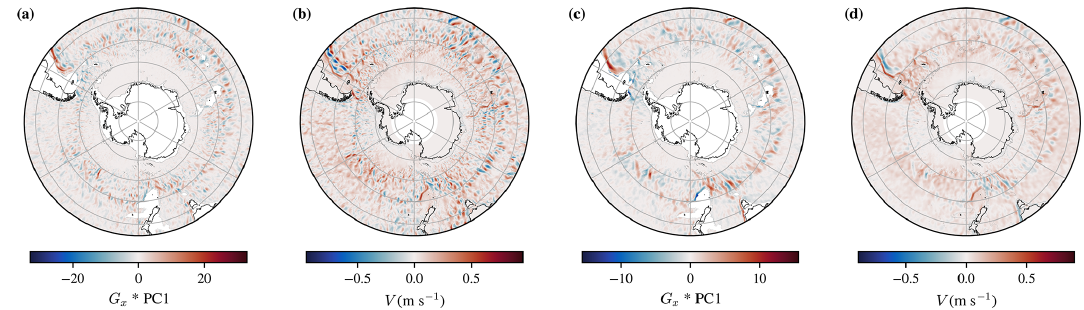
Figure A3. A comparison between the G y ∗ PC1 Sobel edge detection field and the meridional velocity, V , at 2m. Panels (a) and (b) are from the monthly mean over June 2011, whereas panels (c) and (d) are the mean over all of the monthly means in the